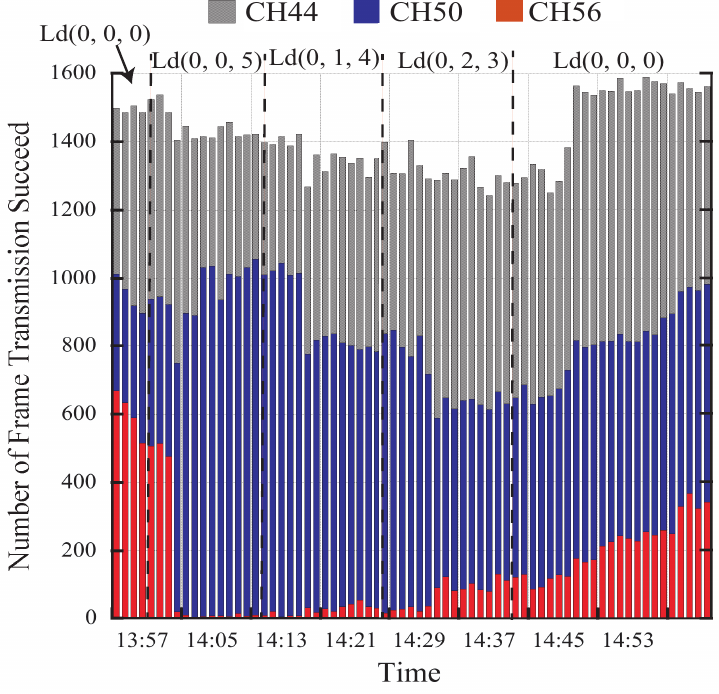
Figure 11. Number of frame transmissions over each available